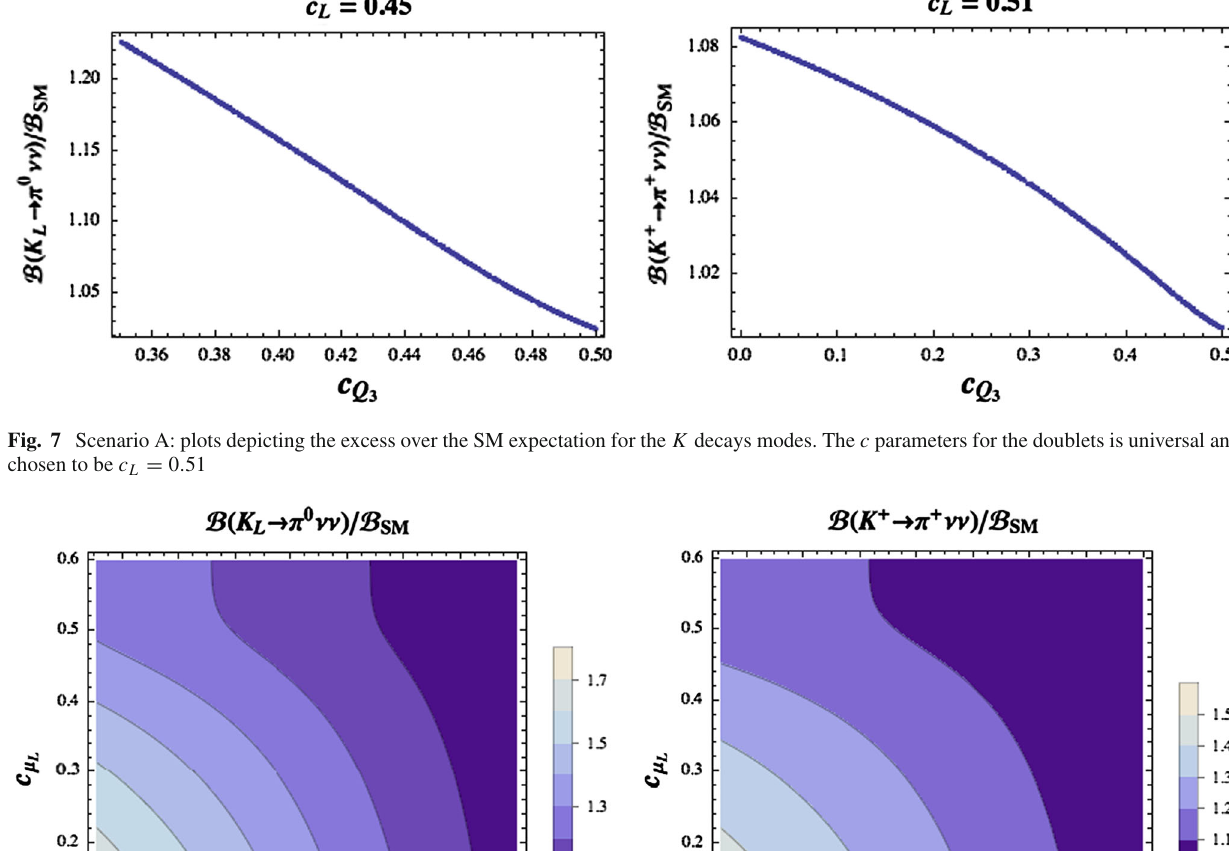
Fig. 8 Scenario B: plots depicting the excess over the SM expectation for the K decays modes. c τ computation while c μ